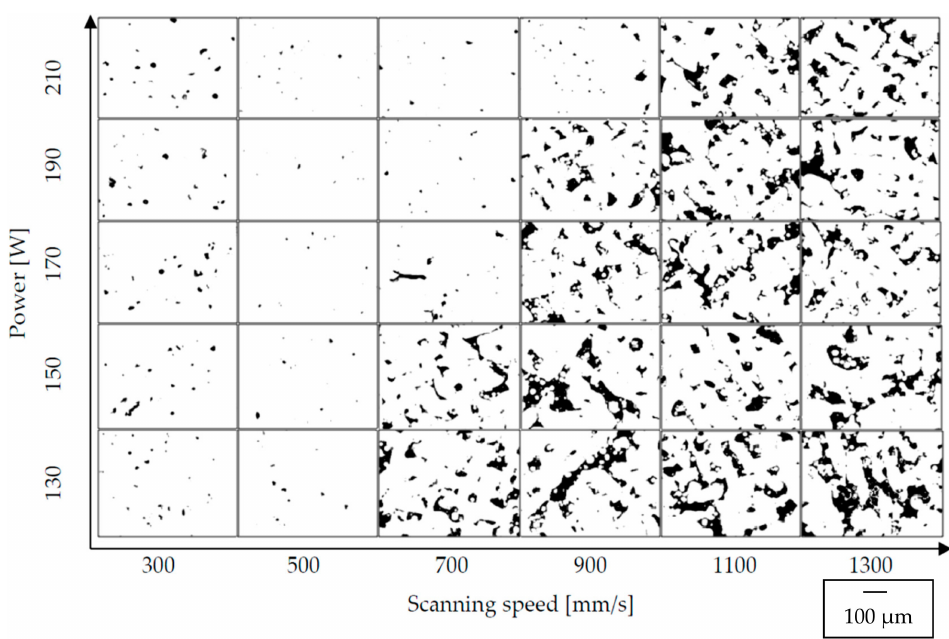
Figure 2. Graphical representation of the variable pore morphology in vertical samples manufactured with Direct Metal Laser Sintering (DMLS) technology, perpendicular to the build direction; 100 ×